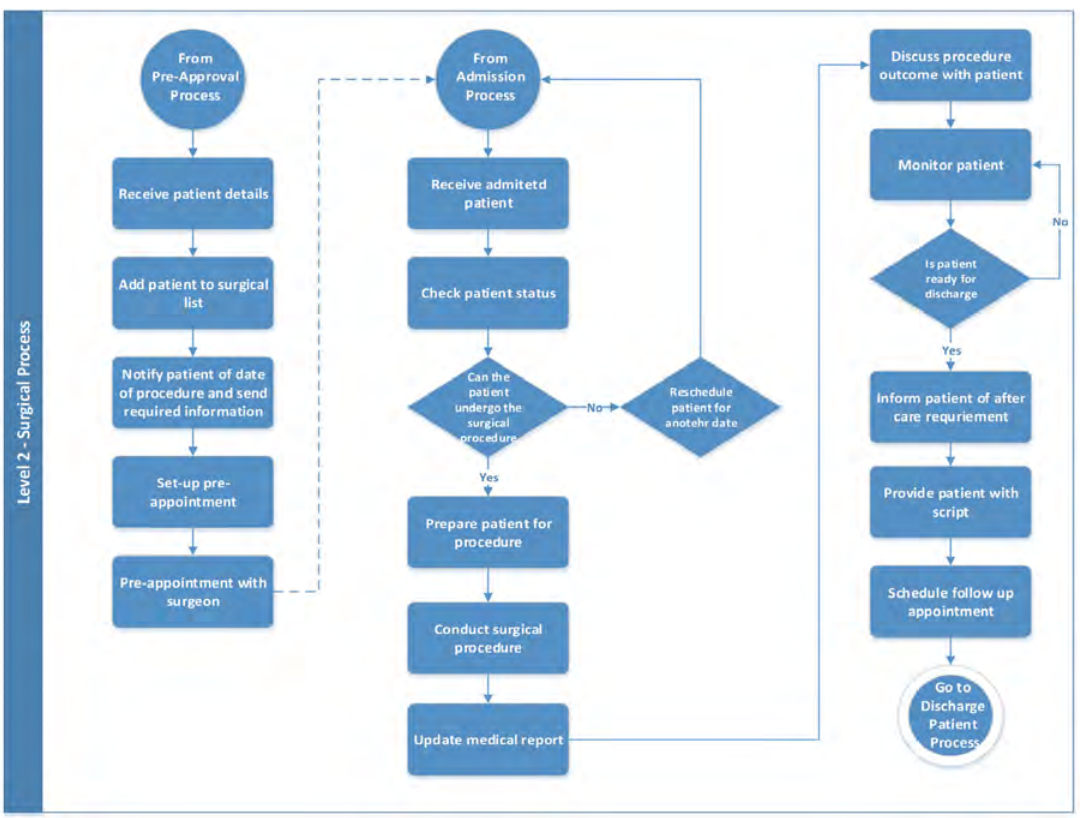
Figure 2. Surgical business process model